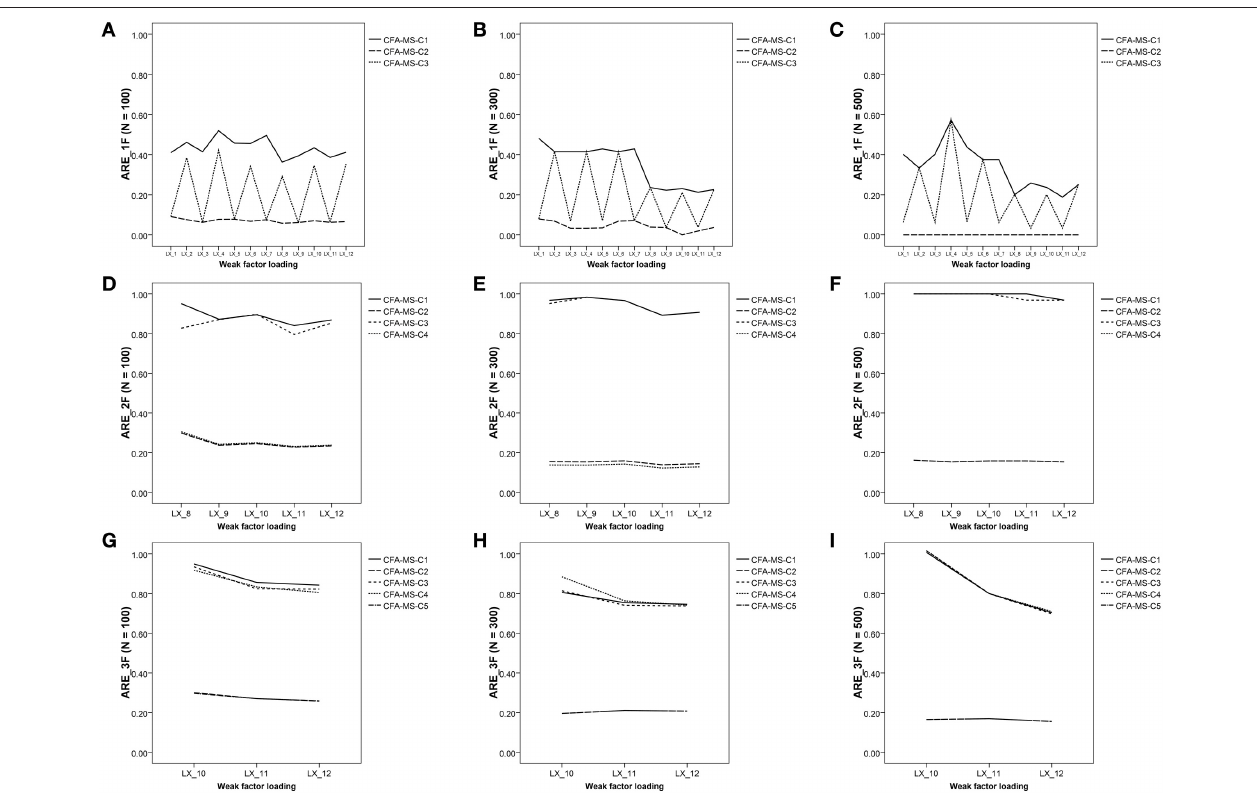
FIGURE 2 | Graphical representation of ARE values in the weak factor loadings of the different model. (A) ARE values in 1F model ( N values in 1F model ( N 300 ); (C) ARE values in 1F model ( N = 2F model ( N 500 ); (G) ARE values in 3F model ( N =